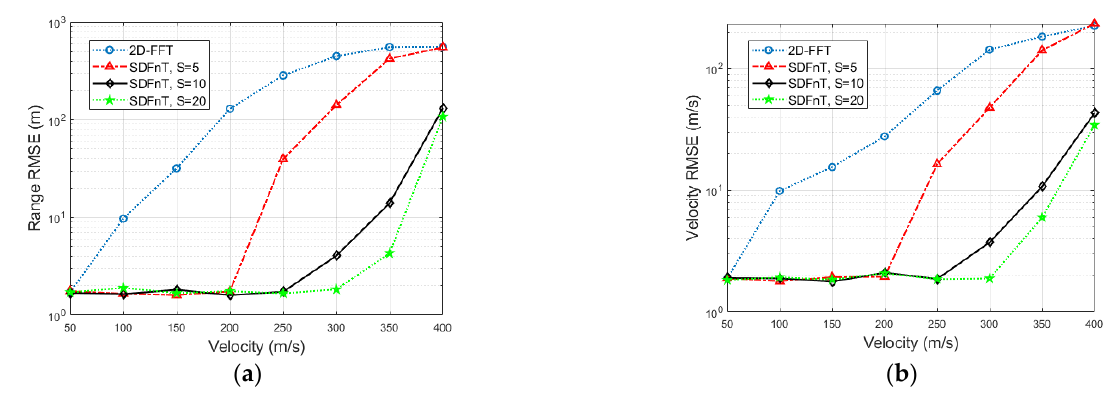
Figure 3. Estimation accuracy comparison in terms of velocity ( a ) RMSE for the range estimation ( b ) RMSE for the velocity estimation.